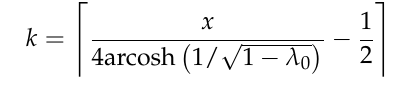
Figure 3. (Color online.) The normalized relative value L Up , nor The white dashed curves correspond to the optimal parameter δ opt of Equation